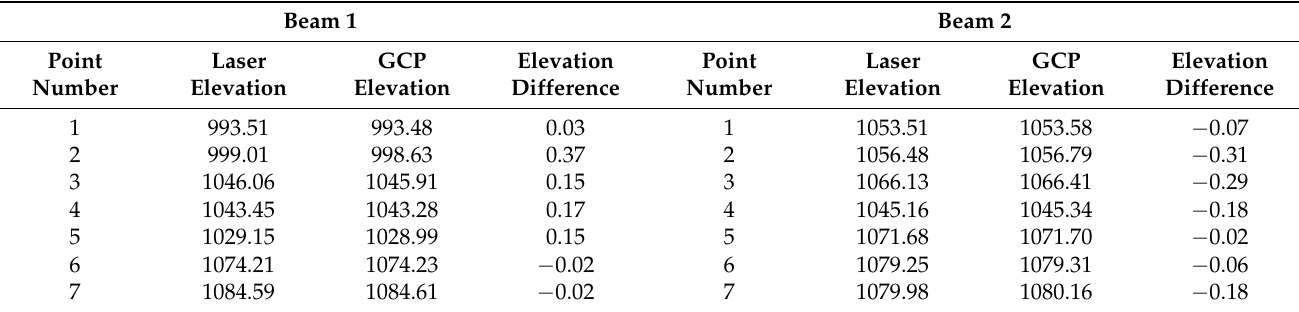
Table 7. The elevation accuracy of the GF-7 laser beams 1 and 2 after iterative calibration based on